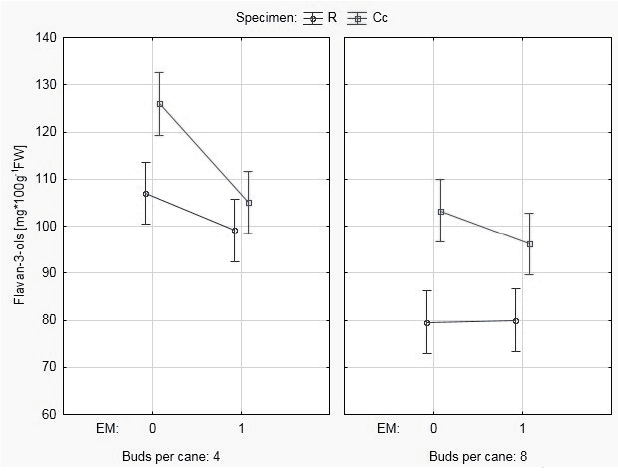
Fig. 5: Effect of the performed treatments on flavan-3-ol content (in mg 100 g -1 FW) in the fruits of the tested vine cultivars